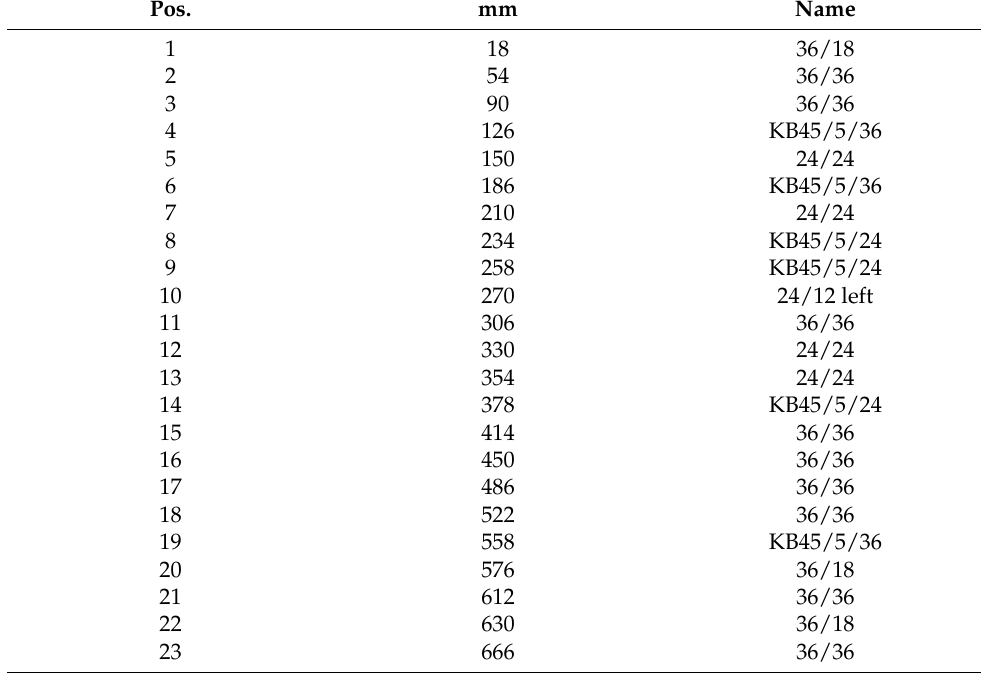
Table A1. Listing of the screw elements of the twin screw